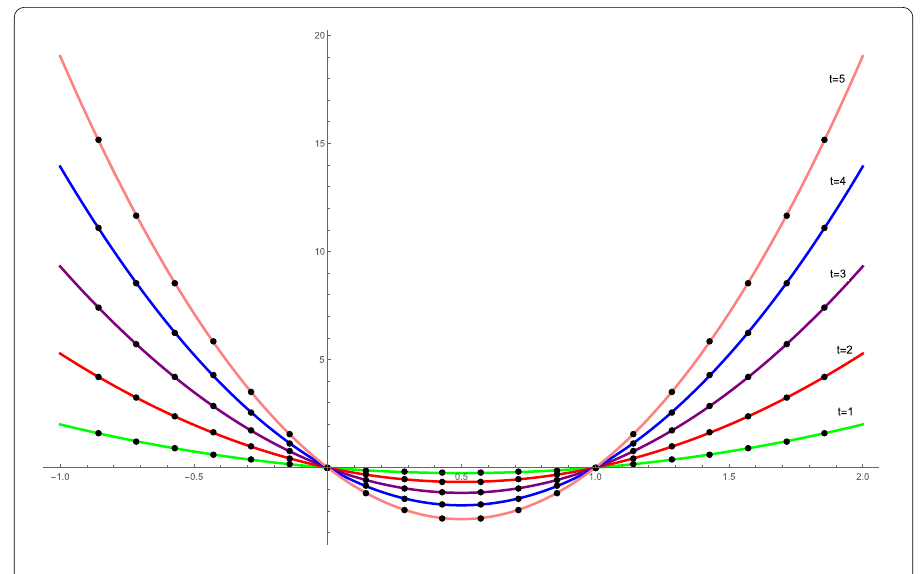
Figure 3 Exact and approximate solutions for Example 1 when N = 60, (cid:3) t = 0.001, α = 0.4, and –1 ≤ z ≤ 2